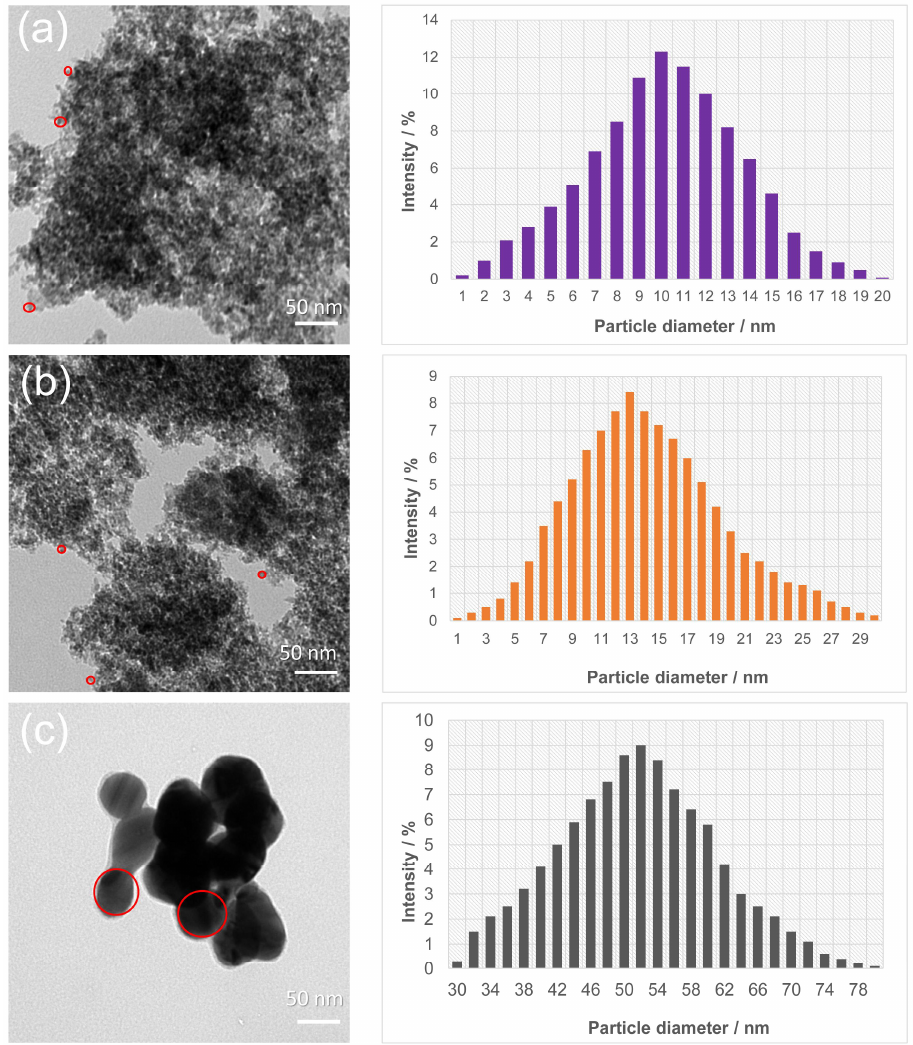
Figure 3. Transmission Electron Microscopy (TEM) images (left panels) and diagrams of particle diameter (right panels) obtained for ( a ) TiO 2 NPs, ( b ) TiO 2 /SiO 2, and ( c ) TiO 2 /Ag (single nanostructures are marked with a red circle).